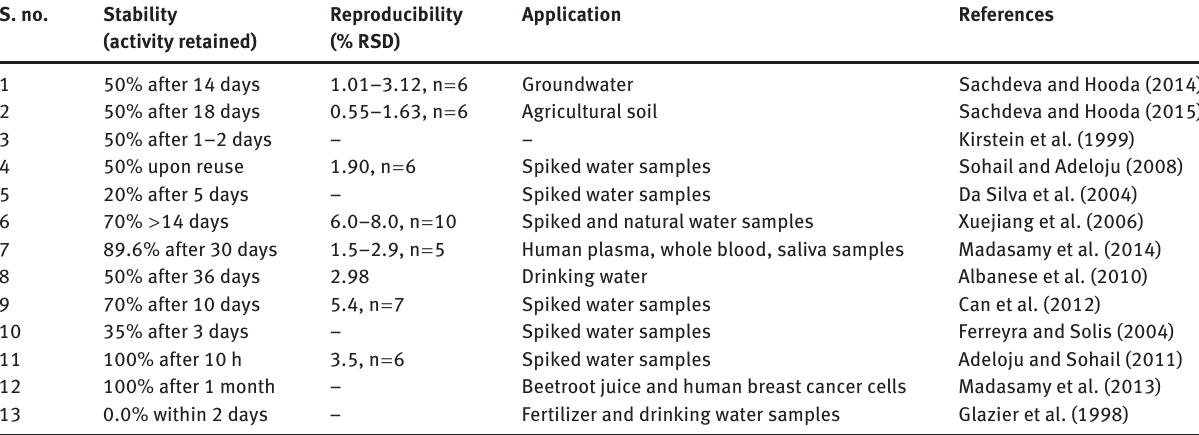
Table 4: Storage stability, reproducibility and application of various immobilized NR-based methods. S.